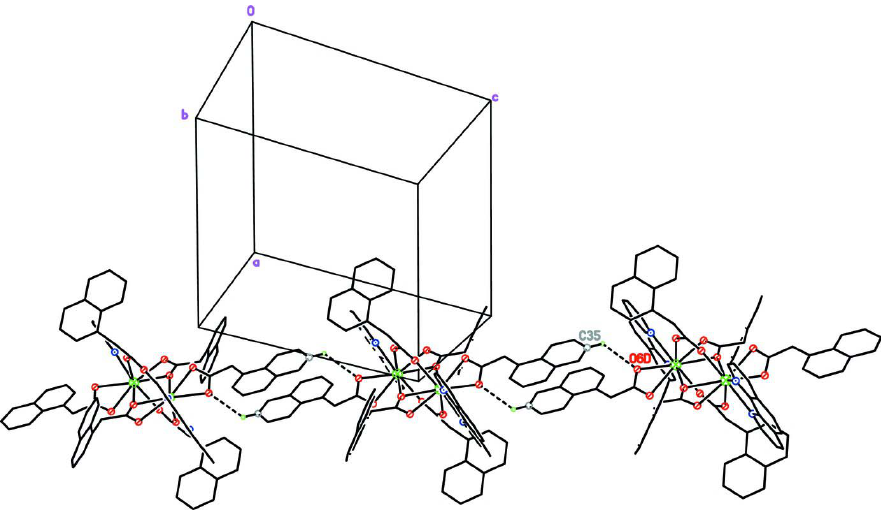
Figure 4 A larger portion of the crystal structure of (I), showing the formation of a hydrogen-bonded chain built from C—H···O. For clarity, H atoms not involved in the hydrogen bonding have been omitted. Dashed lines indicate hydrogen bonds [symmetry codes: (D) 2 - x , 1 - y , 3 - z ]. Tetrakis( µ -naphthalene-1-acetato-1:2 κ 2 O:O ′ )bis(naphthalene-1-acetato)-1 κ 2 O,O ′ ;2 κ 2 O,O ′ -bis(1,10- phenanthroline)-1 κ 2 N,N ′ ;2 κ 2 N,N ′ -europium(III)samarium(III) Crystal data H O ) (C H N ) ] [EuSm(C 12 9 2 6 12 8 2 2 = 1773.87 M r